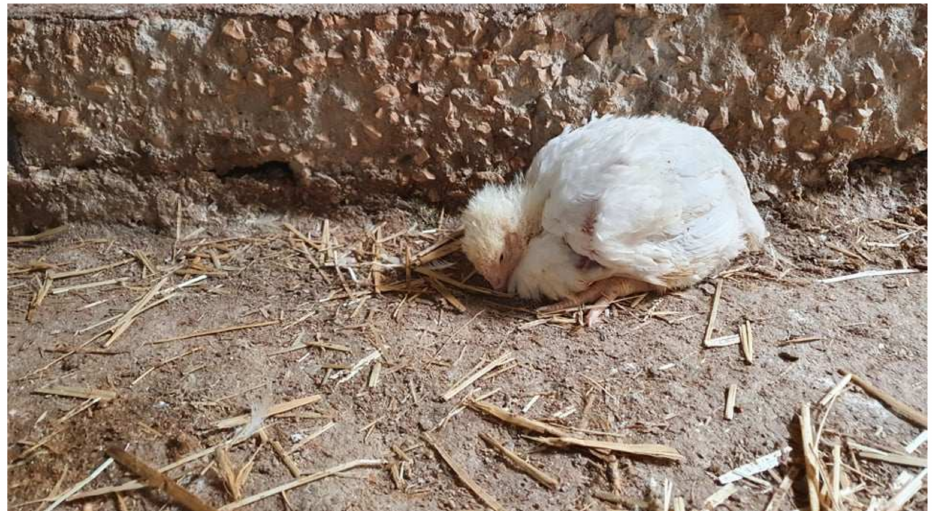
Figure 1. An affected 23-day old broiler chicken from Flock A. The bird revealed non-specific clinical signs including depression, lethargy, ruffling feathers, and